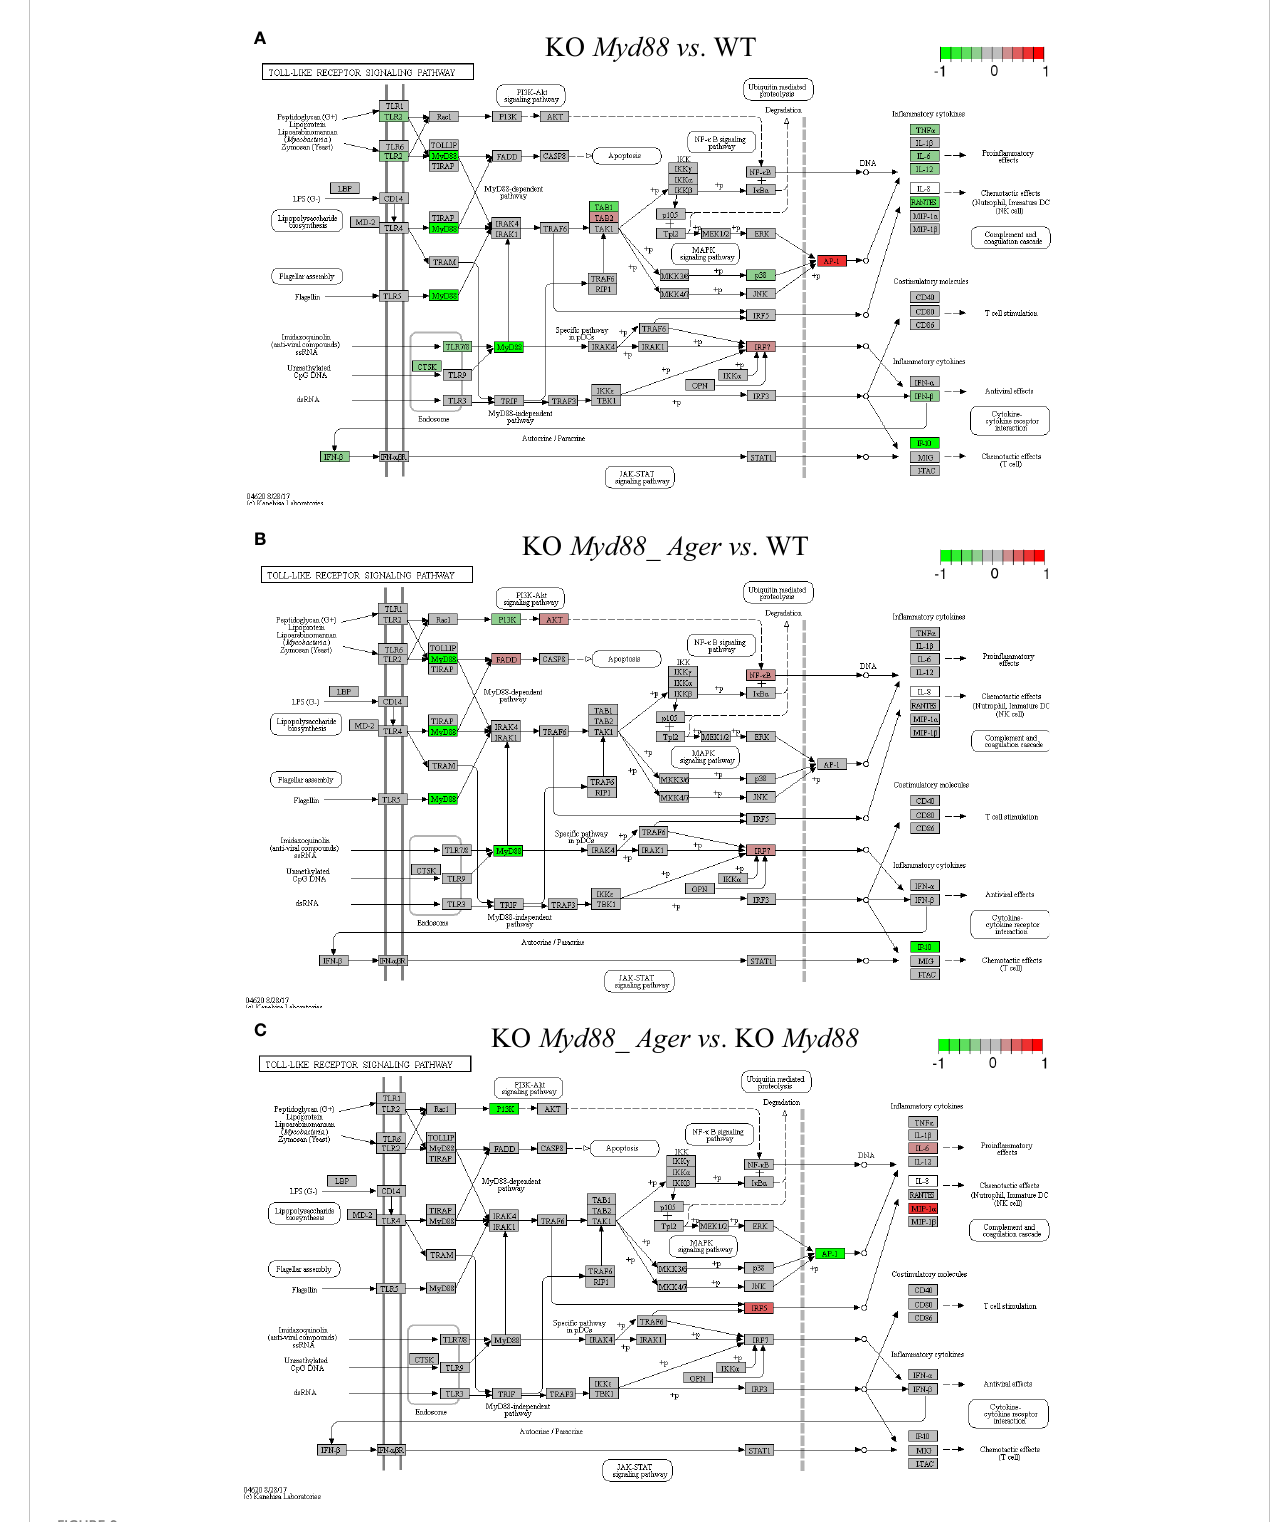
FIGURE 9 Comparison of the rendered Toll-like receptor signaling pathway (mmu04620) identi fi ed by the SPIA method. This target basal TPKO signaling pathway is solely responsible for the Myd88 -null phenotype and is signi fi cantly inhibited in de fi cient mice compared to wild-type mice. The opposing roles of the (A) single Myd88 -null and (B) double Myd88_Ager -null mutants highlight the global effects of key regulators (e.g., MyD88, NF k B, AP1 and cytokines) on orchestrating innate in fl ammatory responses at the systems-level. Treatment (C) re fl ects the subtractive difference between treatments (A, B) . (A) GSE22873_M; (B) GSE22873_MA; (C)